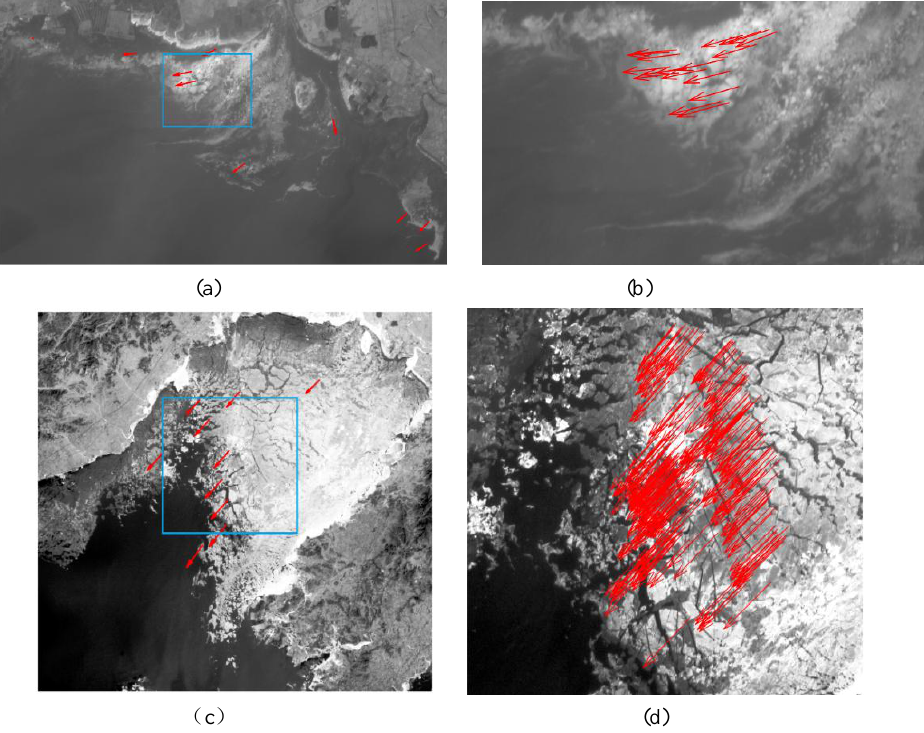
Fig. 6 (a) (c) Sea ice monitoring based on MCC for 2017/1/06 and 2018/2/06 respectively ， (b)(d) Sea ice monitoring based on sift in the blue area of the two images, respectively.